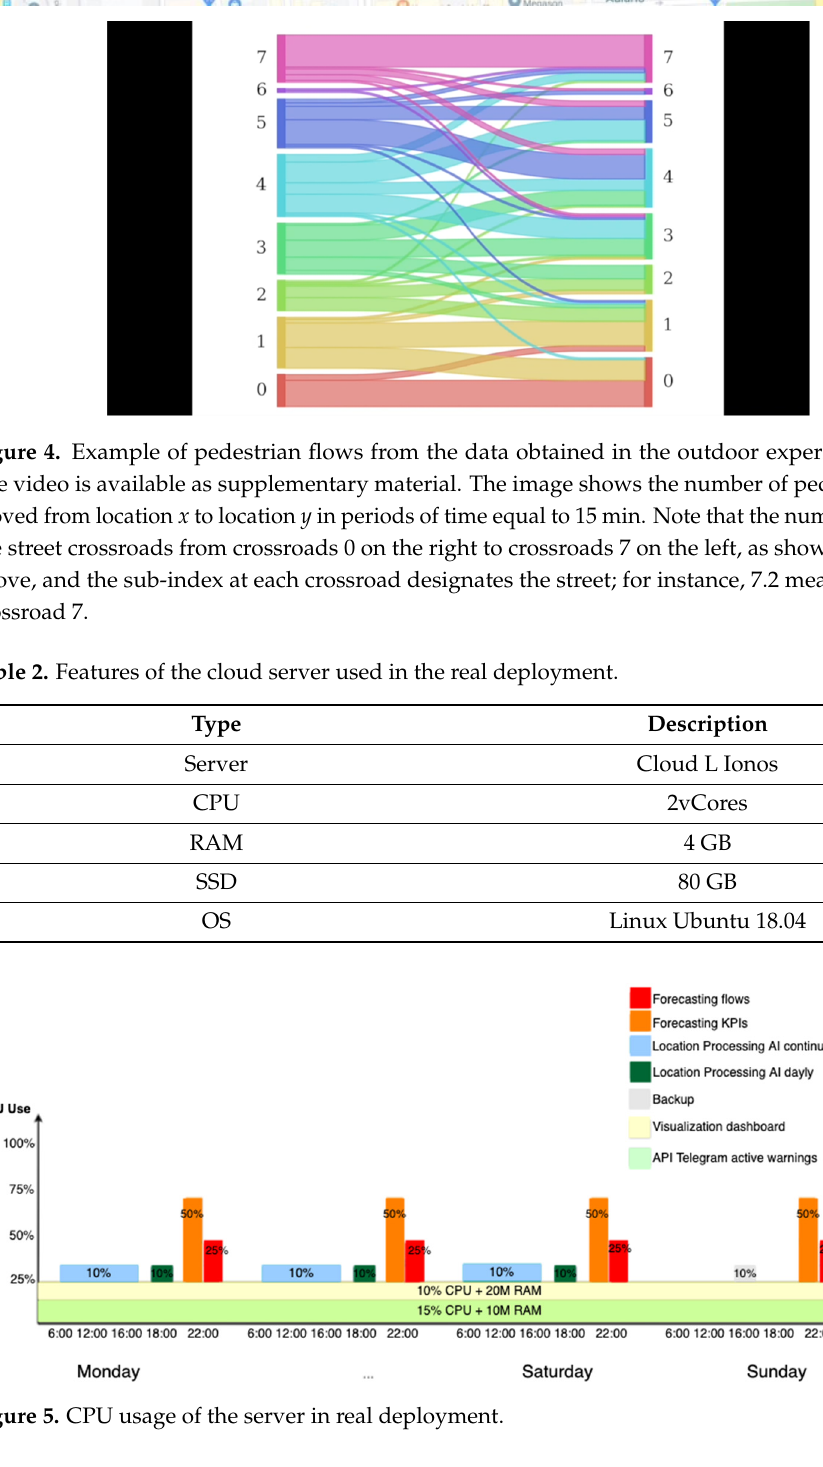
Figure 6. Graphical interface for the user showing the KPI of one day during the real deployment in an indoor environment. Upper left: overview panel of the developed EWS platform; Upper right: people flows, starting from the entrance of the building and showing two levels of depth, first the top three visited locations from the entrance (i.e., where do people go once has entered the build- ing?), and second, the next top three visited locations from the previous three places; Lower center: heatmap with people density in the two floors of the monitored area. As shown in Figure 7, the platform shows the number of people in real time (in Figure 7, it can be observed that the current capacity was 2%). This information is configurable, so it is possible to show the capacity of the complete monitored building or a specific area within. Therefore, it can be used to control indoor capacity either for a complete area or for smaller specific zones (e.g., rooms, offices, store sections, etc.). Another important fea- ture shown in Figure 6 (lower center) is the heatmap, highlighting the people density in the monitored zone. To facilitate the warning process, a chat bot was also developed using the commercial application Telegram [53] using APIs (see Figure 7, Left). In this case, the warning system is bidirectional, being possible to automatically notify the subscribers of specific events (e.g., capacity above a given limit, people proximity exceeded for a given time, and so on) or to answer specific questions made by the users about the KPIs. The complete EWS was built in six months, deployed in the real indoor scenario in two weeks,